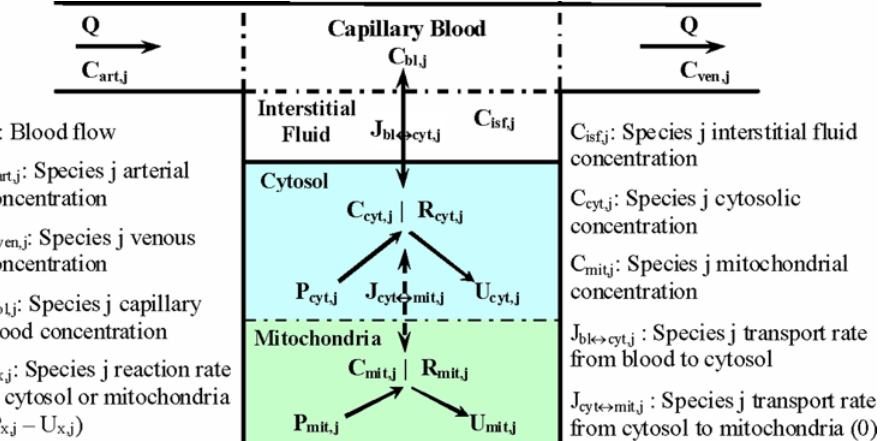
Figure 2. Schematic diagram of the structure of the model for blood-tissue cells exchange and cellular metabolism in skeletal muscle. The compartments are assumed to be perfectly mixed, and the capillary blood and tissue ISF regions are assumed to be in phase- equilibrium with each other, so that C isf,j = C bl,j = C ven,j for any chemical species j . The tissue cells domain is further compartmentalized into the cytosolic and mitochondrial domains with the chemical species having the similar dynamics in these two subcellular domains, so that C mit,j ( t )= s j C cyt,j ( t ), where s j is the partition coefficient of the species j between cytosol and mitochondria. The model accounts for 30 chemical species in the tissue cells. A total of 8 species (GLC, LAC, PYR, ALA, FFA, GLR, CO 2 and O 2 ) undergo blood-tissue cells exchange; 10 species (PYR, FAC, CoA, NADH, NAD + , ATP, ADP, PI, CO 2 and O 2 ) exist in both the cytosolic and mitochondrial domains with a negligible transport flux ( J cyt « mit,j < 0). For details, see the caption of Figure